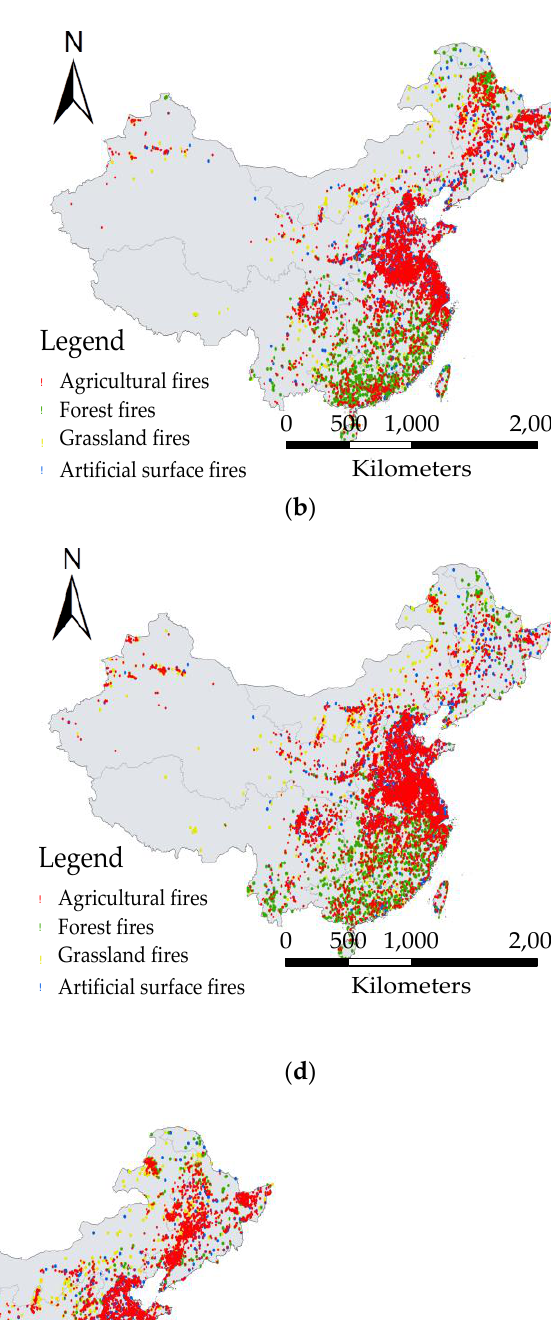
Figure 3. Monthly distribution of the fires in China within the predominant land cover types from 2010 to 2014: ( a ) agricultural fires; ( b ) forest fires; ( c ) artificial surface fires; ( d ) grassland fires.